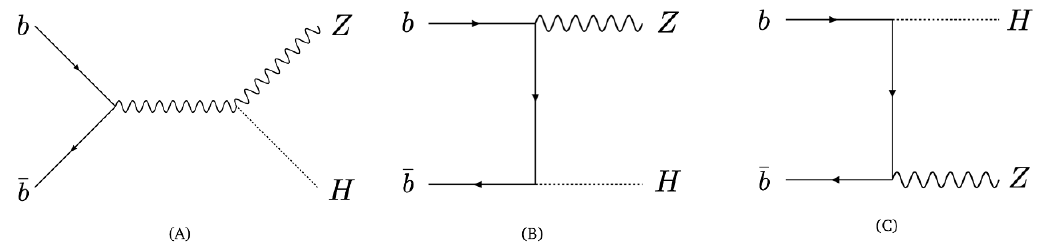
Figure 1 . Feynman diagrams at leading